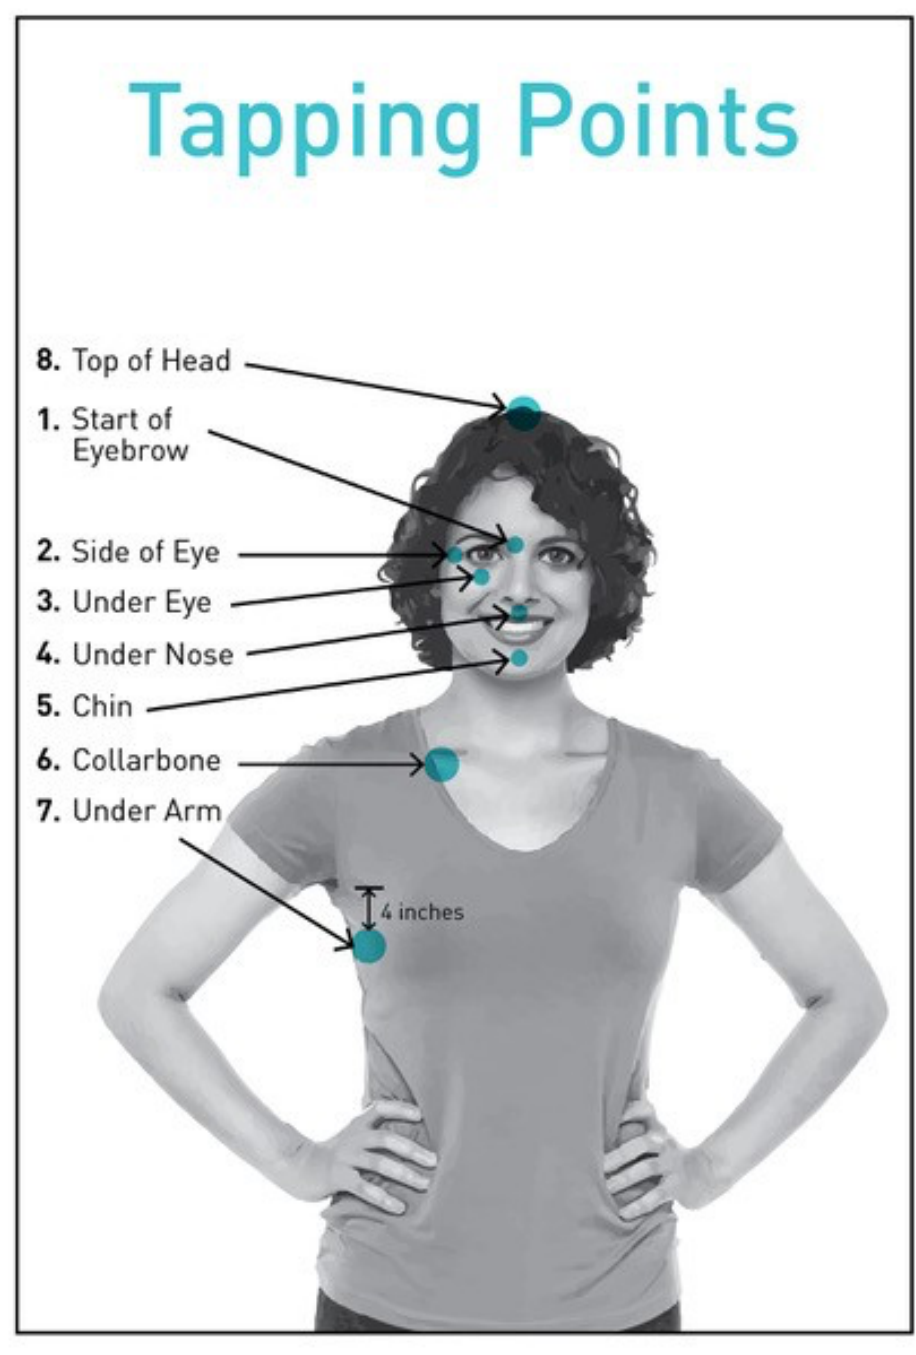
Figure 1. Eight tapping points utilized in Emotional Freedom Techniques practice. The Tapping Solution App includes a point on the side of the hand. Copyright 2019 by Peta Stapleton. Reprinted with